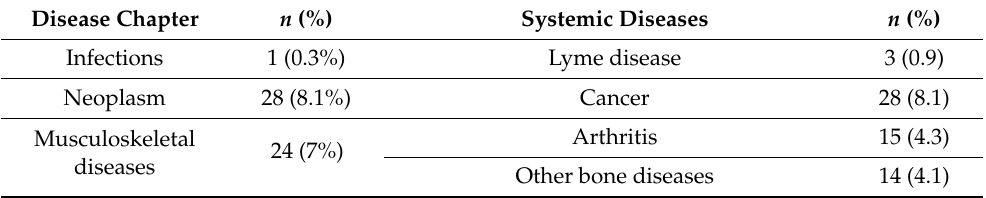
Table 2. Distribution of patients over the various disease chapters and specified systemic